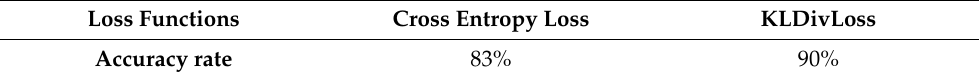
Table 5. The parameter setting.